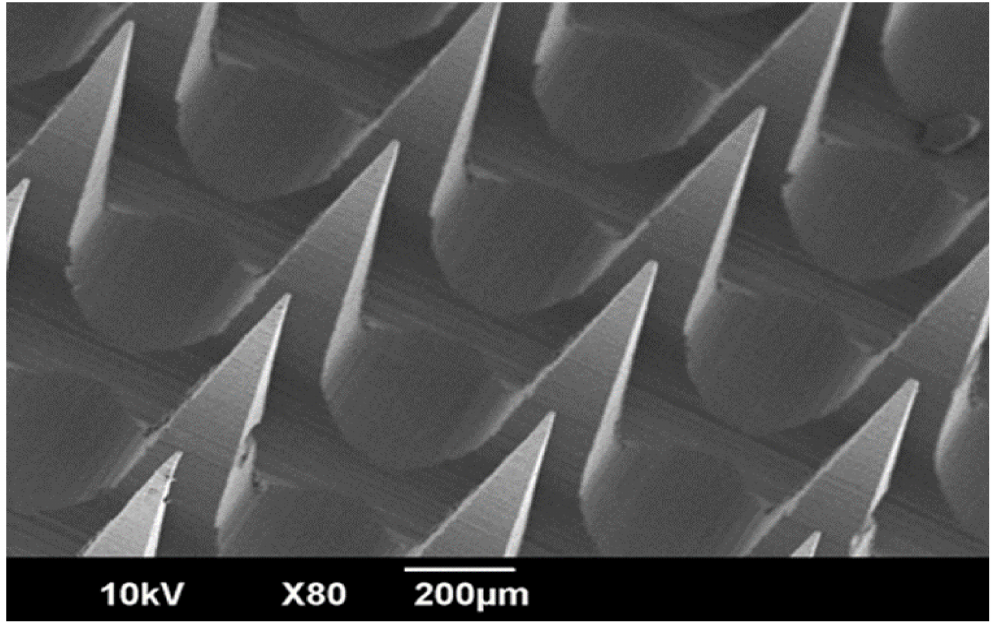
Figure 6. SEM image of LS-TC-MNP-3, showing polyhedral pyramidal-shaped microneedles with a smooth surface. The patch consists of 100 needles in 10 rows each with 10 needles. The length of the needle was 575 µ m having sharp pointed end and base diameter of 200 µ